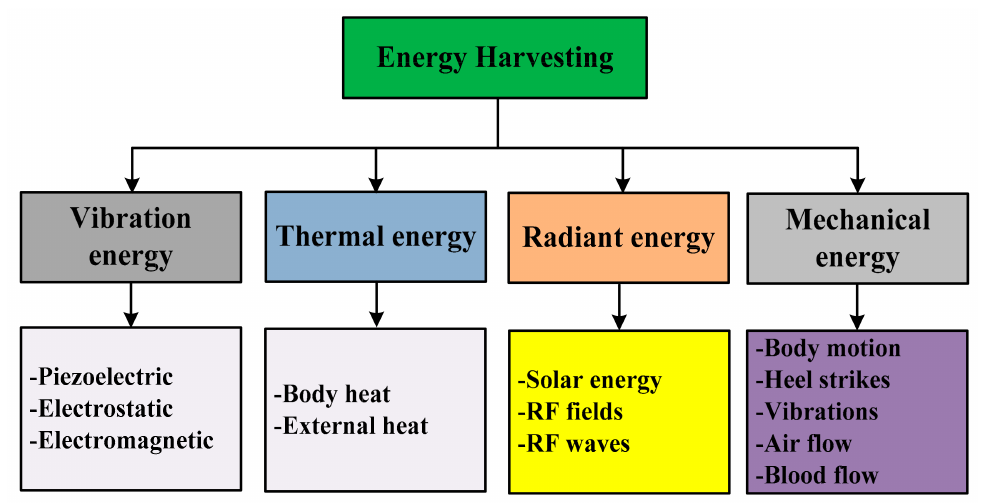
Figure 2. Ambiance energy